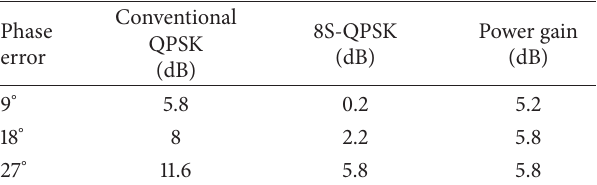
Table 3: Comparison of power gain between the 3 phases error at BER of 10 −2